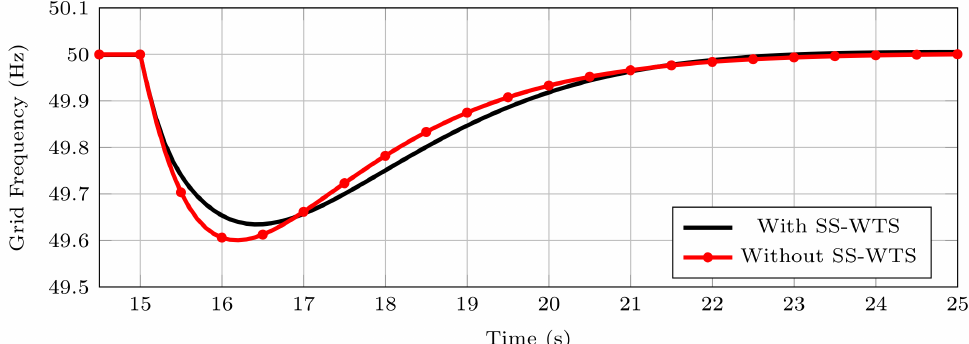
Figure 11. Grid frequency variation for a 5% loss of generating capacity ( ∆ P e ) with and without a SS-WTS connected to the